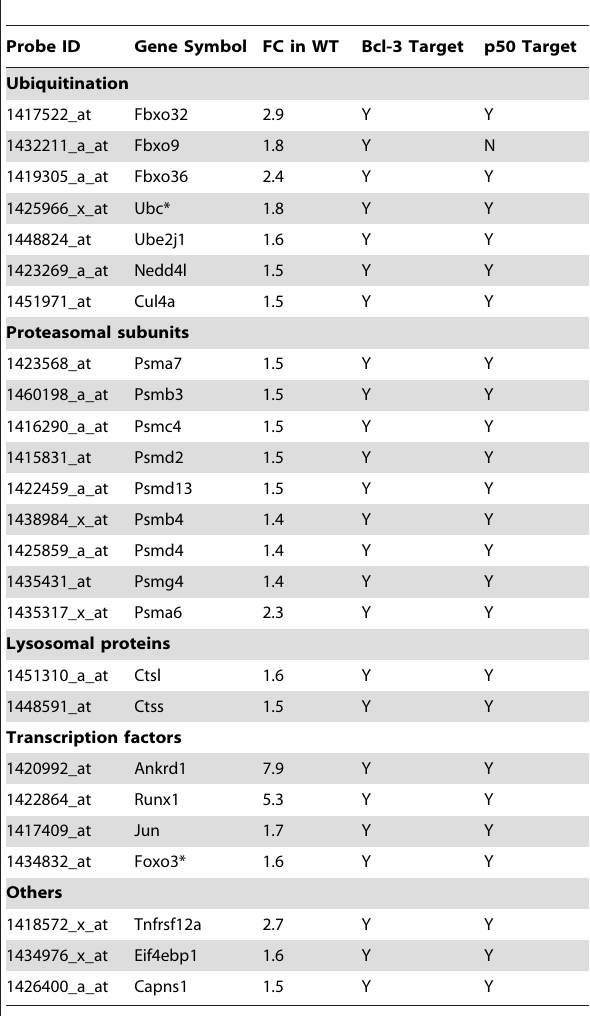
FC=‘‘fold change’’ of gene expression in weight bearing vs. hind limb unloaded groups in wild type animals from microarray analysis. Y=a target gene for Bcl-3 or p50, N=not a target gene for Bcl-3 or p50. *gene significantly increased by t-test but did not pass multiple test